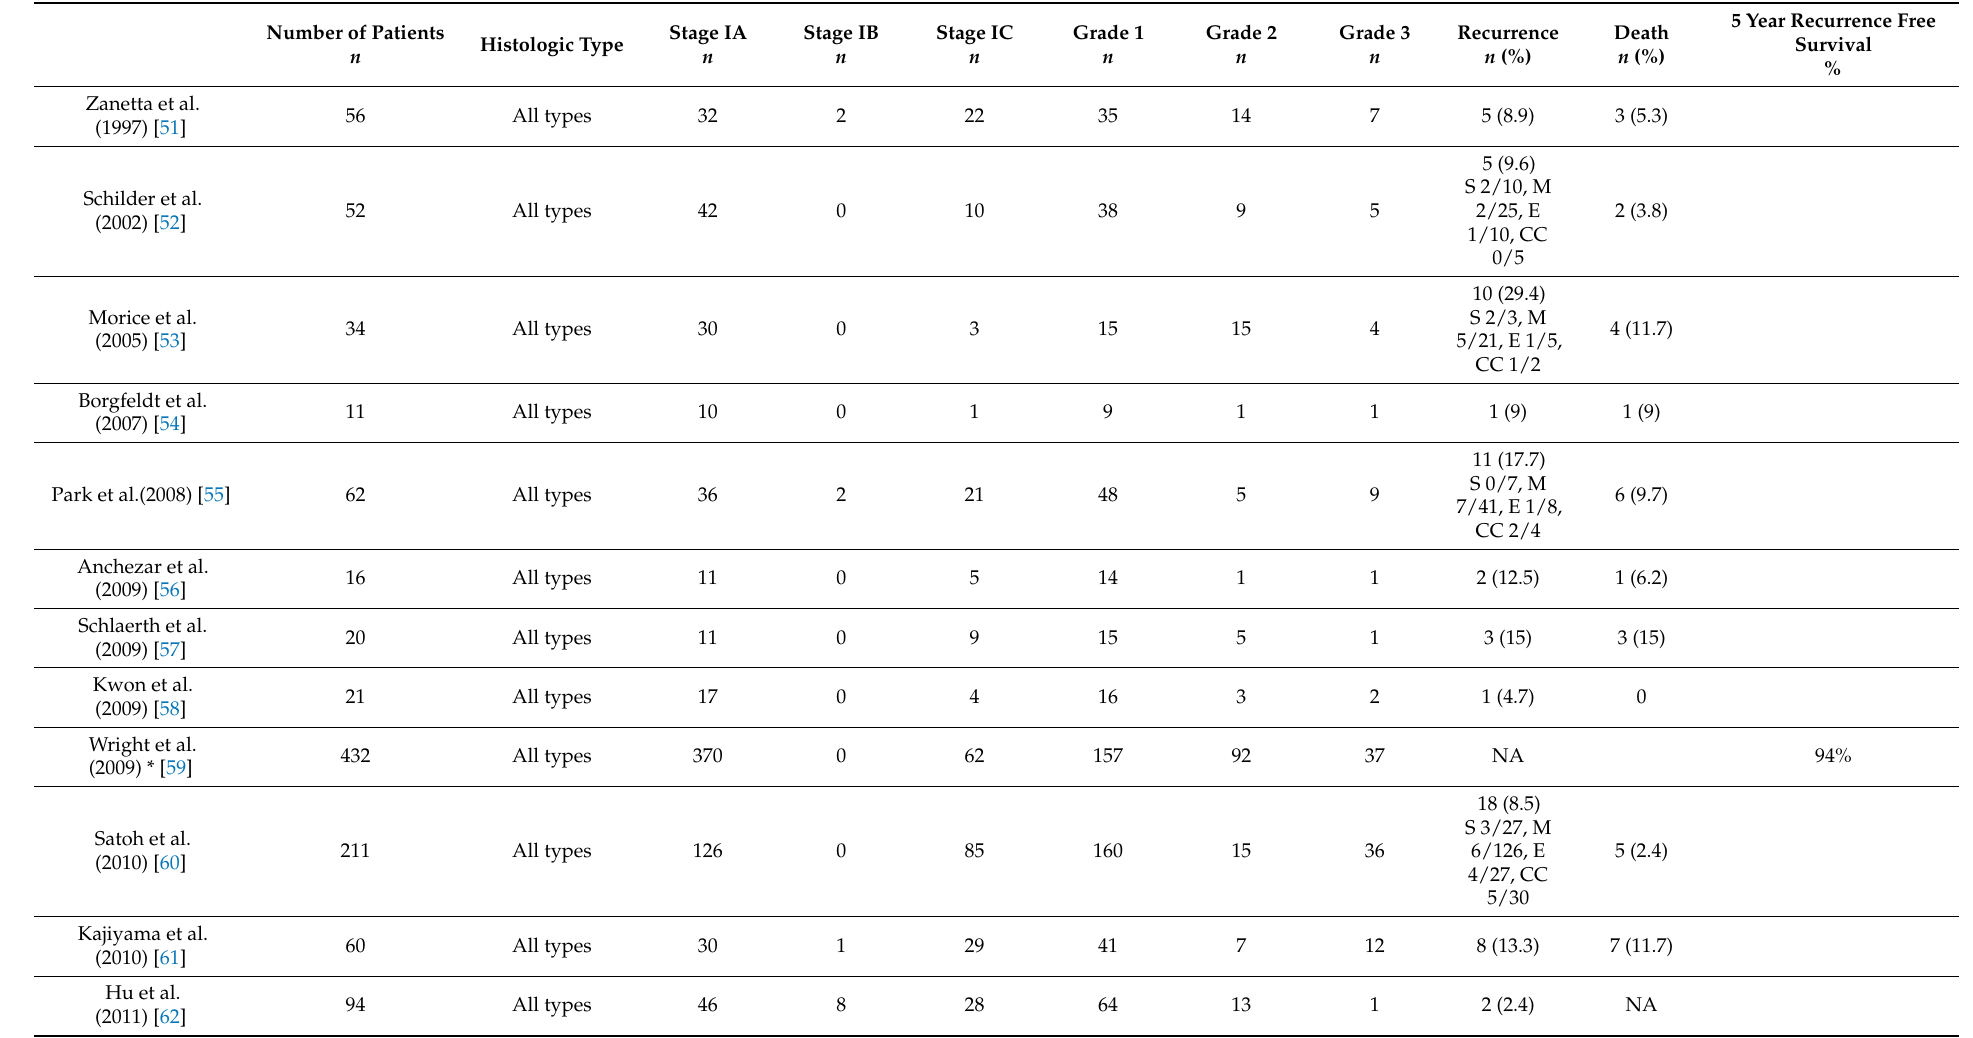
Table 2. Literature review of recurrence risk and survival rates after fertility-sparing surgery for patients with epithelial ovarian cancer. Number of Patients